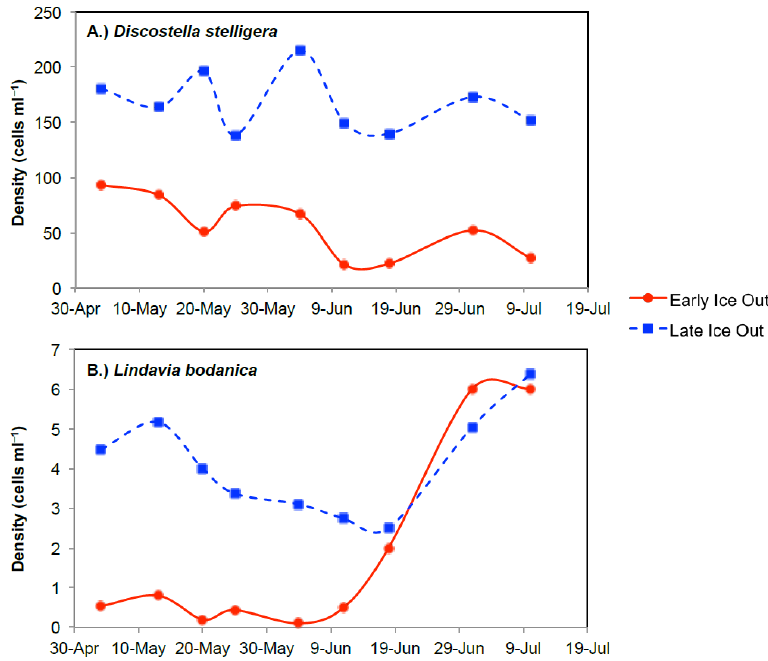
Figure 8. Seasonal comparison of ( A ) Discostella stelligera and ( B ) Lindavia bodanica in the boreal lake from May to mid-July during early and late ice-out years. from May to mid-July during early and late ice-out